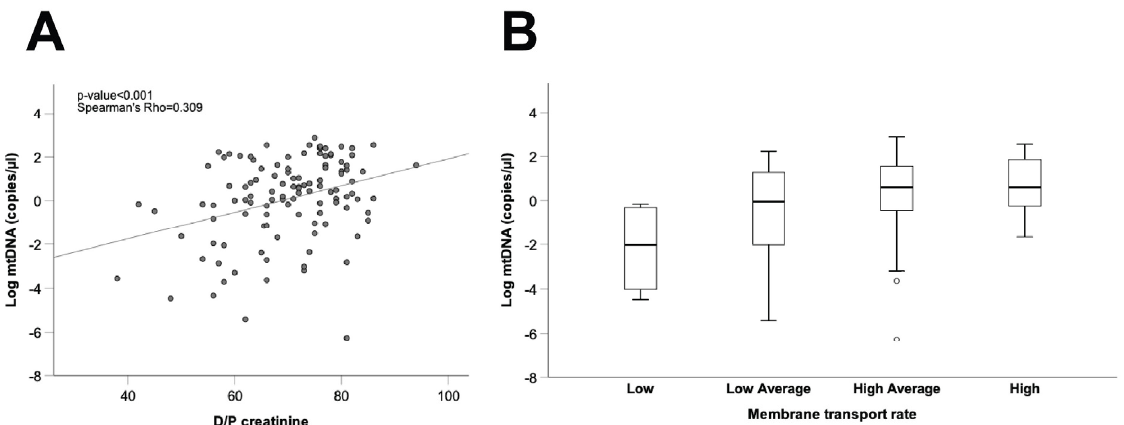
Figure 5. Correlation between free mtDNA in the PD effluent from long vintage patients and the peritoneal transport rate. ( A ) Correlation between mtDNA copy number and D/P creatinine. Spearman’s Rho and p -values are indicated ( n = 113). ( B ) Comparison of PD effluent mtDNA levels between patient groups according to membrane transport type. Data are presented graphically as log base 10 of the raw values of mitochondrial 12S copies per µ L of PD effluent. PD: peritoneal dialysis; D/P creatinine: dialysate/plasma creatinine ratio.